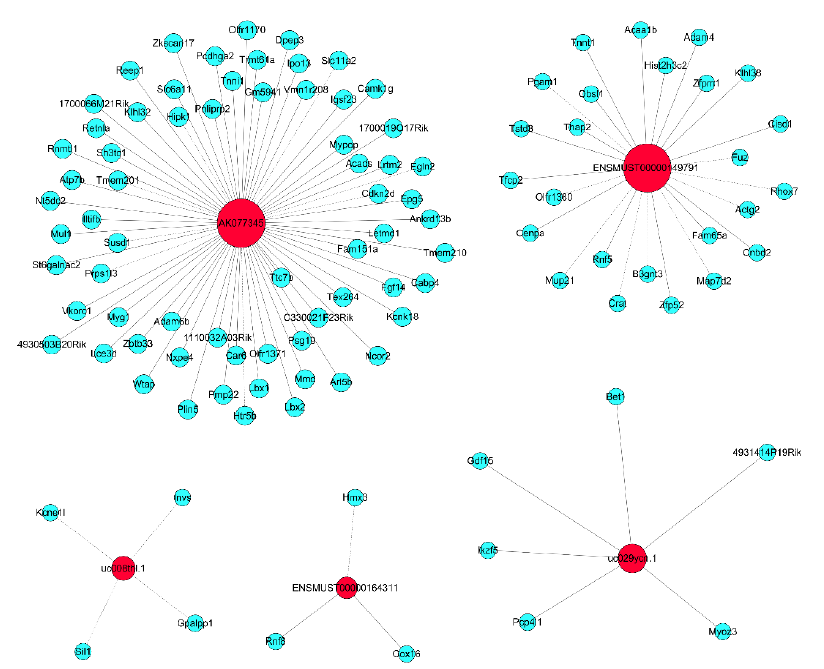
Figure 6. CNC analysis of five lncRNAs with their associated mRNAs. The network is based on the Pearson correlation coefficient (the absolute value of PCC ≥ 0.995, and FDR < 0.05). The red represent lncRNAs and the light blue represent mRNAs.